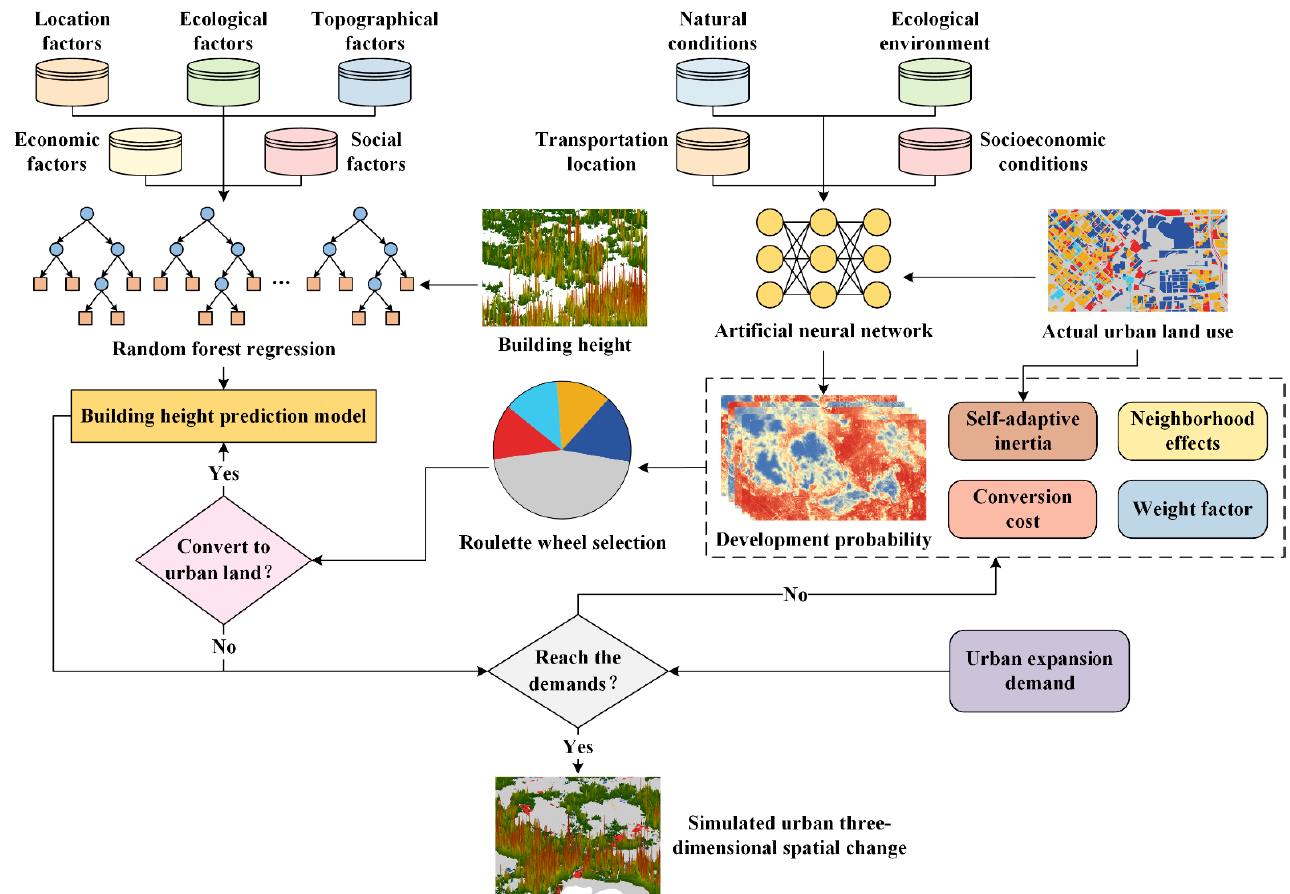
Figure 6. Flowchart of urban 3D spatial expansion simulation model.